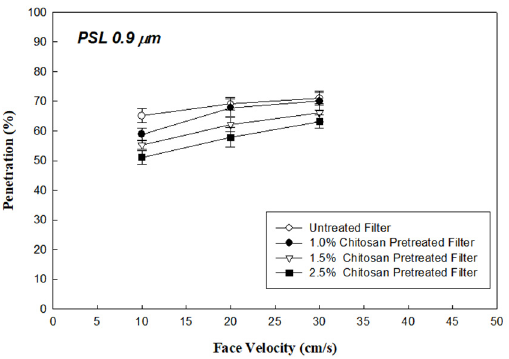
Figure 2. Penetration through the chitosan pretreated and untreated filters for 0.9- μ m PSL aero- sols.